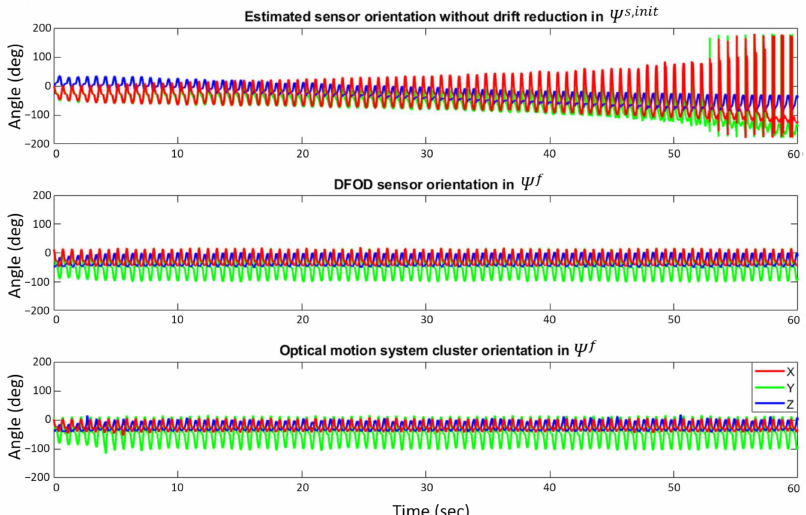
Figure 4. Estimated sensor (inertial) and cluster marker set (optical) orientation for a representative subject. The top figure shows estimated sensor orientation without drift reduction with respect to the initial orientation of the sensor at the start of the first gait cycle ( Ψ s , init ). The middle figure shows the estimated sensor orientation obtained with DFOD in Ψ f . The bottom figure shows the actual cluster orientation according to an optical motion capture system in Ψ f . Note that data of the top graph are shown in a different coordinate system. This figure shows the added drift-reducing benefit of DFOD compared to orientation estimation without drift reduction. Anti-clockwise rotations in Ψ s , init , (top figure), and Ψ f (middle and bottom figure) correspond to positive angles. An angle of zero corresponds to the initial sensor orientation just before initial contact of the first gait cycle in Ψ s , init (top figure) or Ψ f (middle and bottom